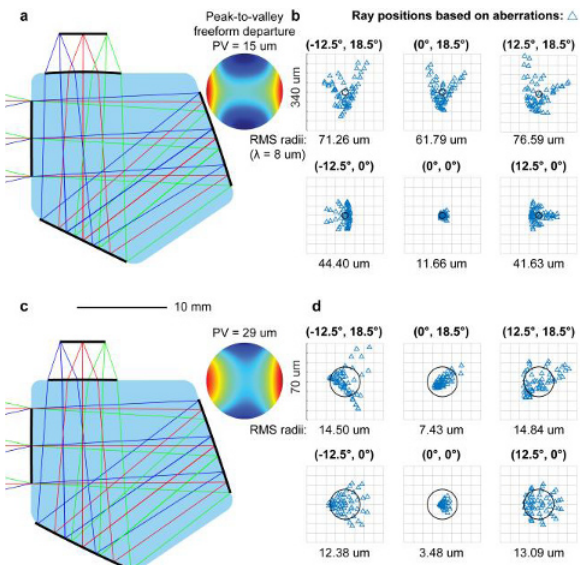
Fig. 3. "First time right" results for the monolithic LWIR design: a Cross-section of directly calculated system. b Spot diagram for six fields based on aberration calculations. c Cross-section of the further optimized system. d Spot diagram for identical six fields.